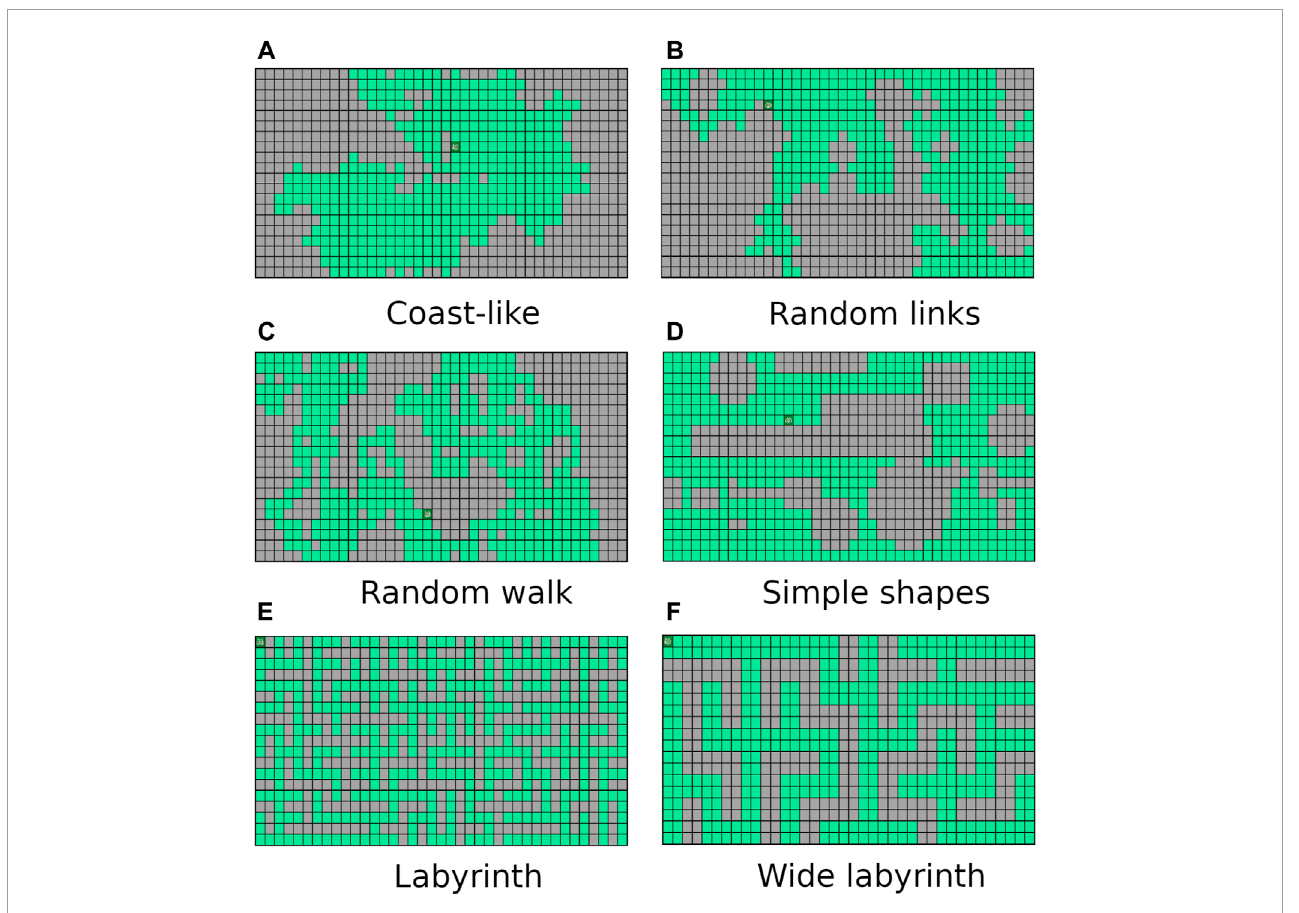
FIGURE 5 The six types of generated grids in our benchmark: (A) Coast-like, (B) Random links, (C) Random walk, (D) Simple shapes, (E) Labyrinth, (F) Wide-labyrinth.